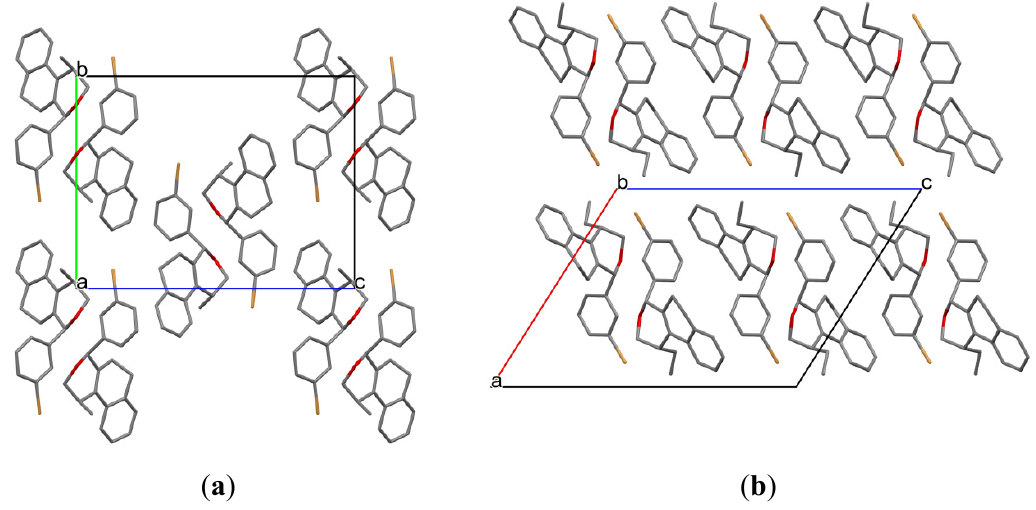
Figure 6. The crystal packing illustration of (a) 7k and (b) 15e onto the ac plane. Hydrogen atoms were omitted for clarity.